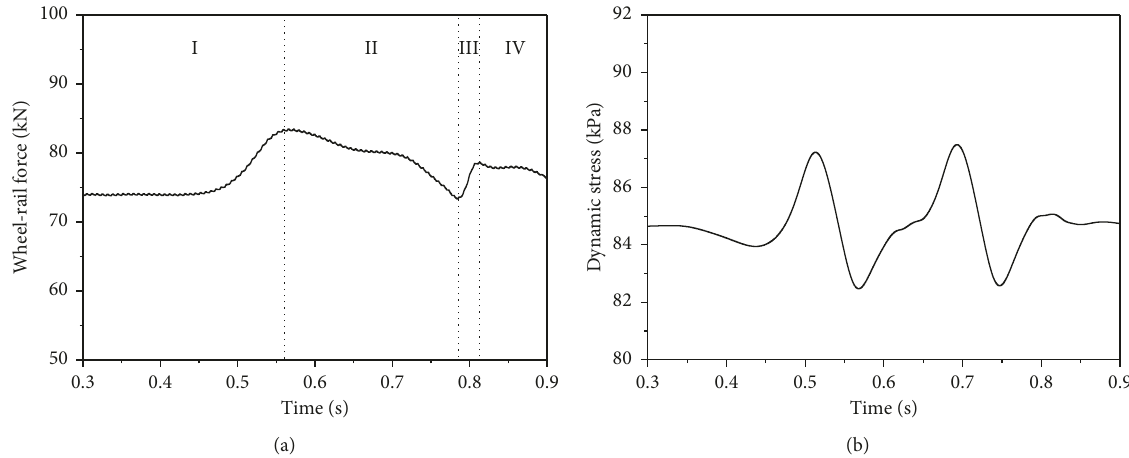
Figure 11: Dynamic responses of the train-transition section system: (a) wheel-rail force and (b) dynamic stress in subgrade bottom